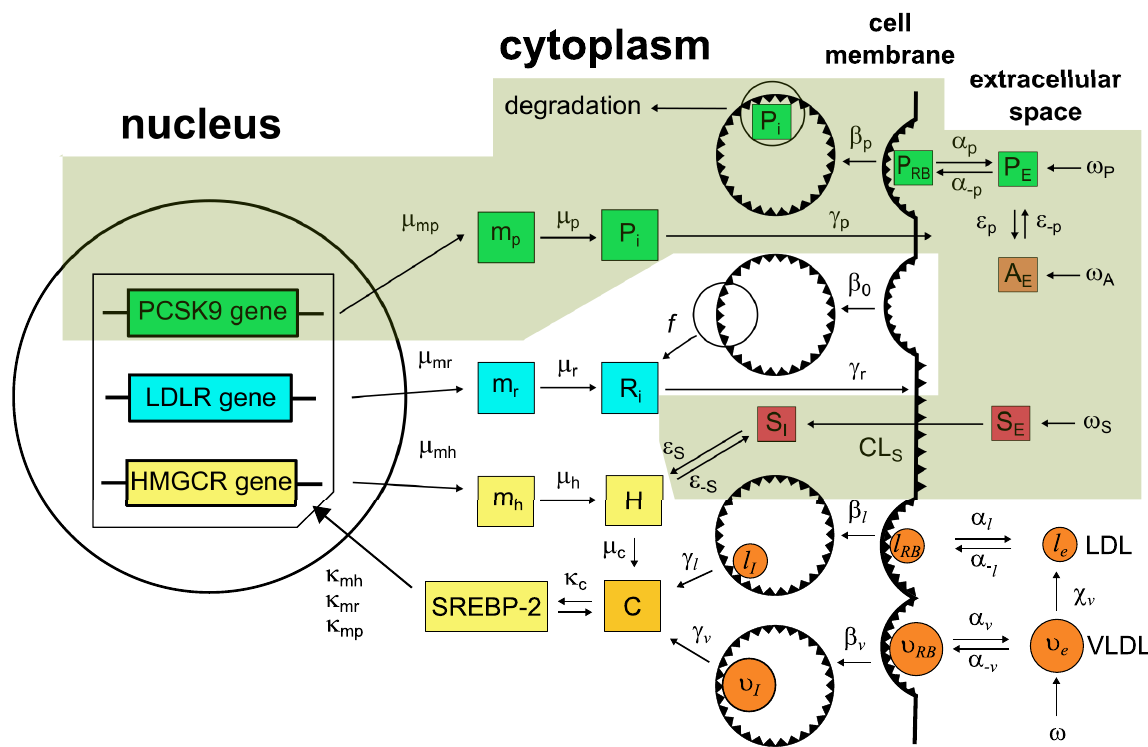
) and c ) also occurs. Statins (S) are internalised p